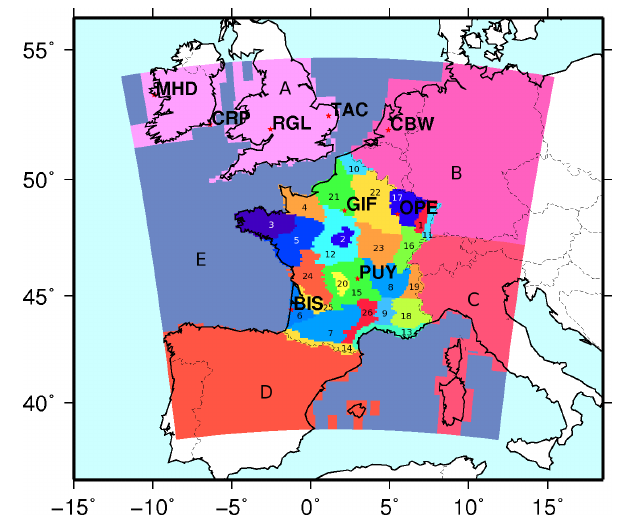
Figure 2. Horizontal grid used by CHIMERE (see Sect. 3.1). Res- olution in the centre (mainland France): 10km × 10km for 98 × 98 grid cells. The sizes of grid cells increase in areas not covering mainland France: 30, 50 and 80km over 3, 3 and 2 rows of grid cells.